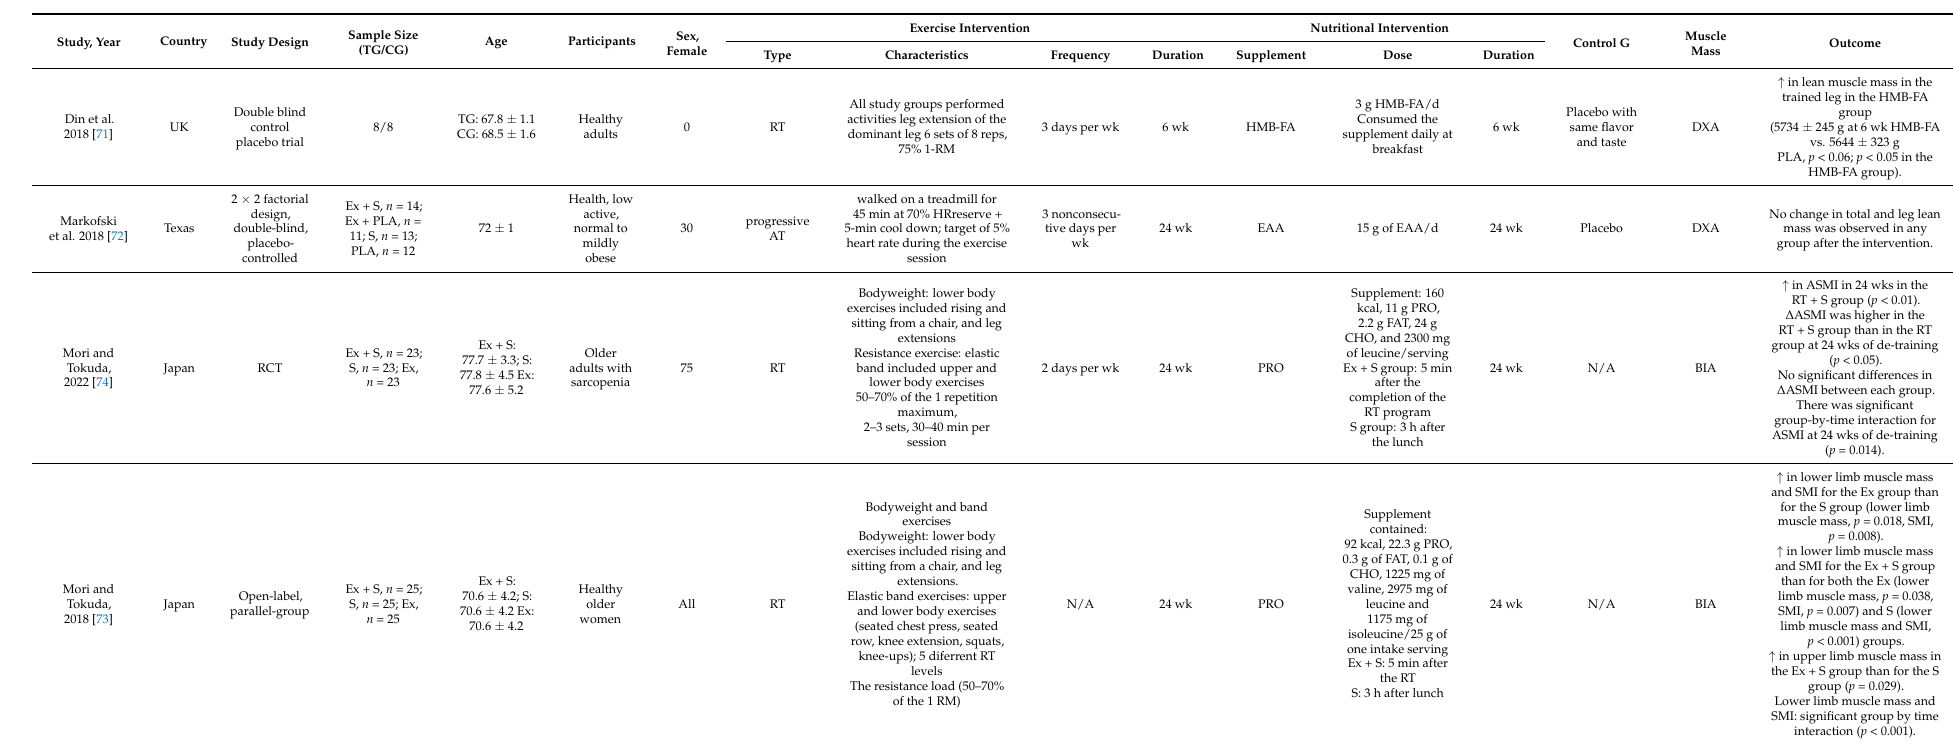
Table 3. Studies that examined the effect of diet and exercise on increasing muscle mass in the elderly.